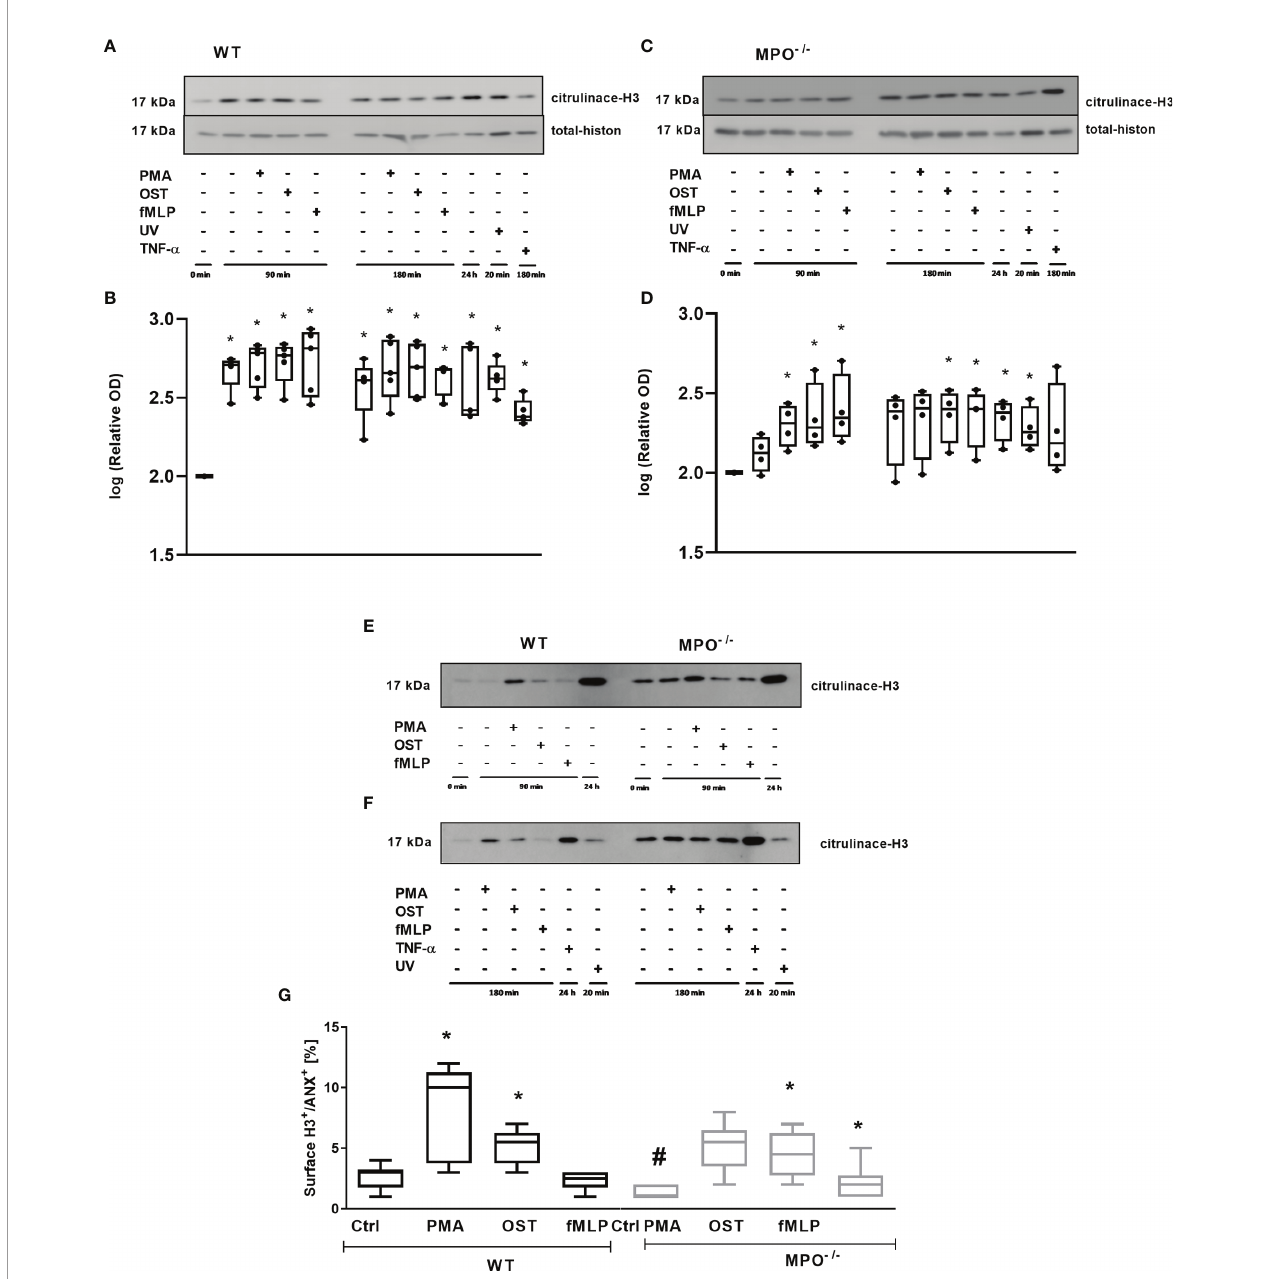
FIGURE 7 | Determination of histone H3 citrullination in PMNs from WT (A, E, F) and MPO -/- (B, E, F) and its surface expression on Annexin V + PMNs (G) . (A – F) - PMNs (1x 10 7 cells/ml) isolated from BALF of WT and MPO -/- mice were stimulated with PMA (80 nM), OST (1:10 MOI) and fMLP (1.14 m M) for 90 and 180 min. PMNs incubated for 24 h without stimulation, PMNs irradiated by UV for 20 min, and PMNs treated by TNF- a (10 ng/ml) for 180 min were tested as positive controls. Total and citrullinated H3 histone was determined by Western blot. Data are presented as median, 25, and 75 percentiles (the box) and 10 and 90 percentiles (the whiskers), and individual values are drawn as individual dots (n = 3). * shows statistically signi fi cant difference (p < 0.05) compared with untreated control (Ctrl). A comparions of histone H3 cintrulination in PMNs from WT and MPO -/- after stimulation with PMA, OST, and fMLP for 90 min (E) and 180 min (F) . (G) – PMNs were evaluated by fl ow cytometry and cells positive for both Annexin V + and citrullinated H3 + were determined after 80 min. n = 3-4 mice per group. Data are presented as median, 25, and 75 percentiles (the box) and 5 and 95 percentiles (the whiskers), and values below and above the whiskers are drawn as individual dots. *Shows statistically signi fi cant difference (p < 0.05) compared with untreated control (Ctrl). # shows statistically signi fi cant difference (p < 0.05) between MPO -/- (MPO-KO) and wild-type